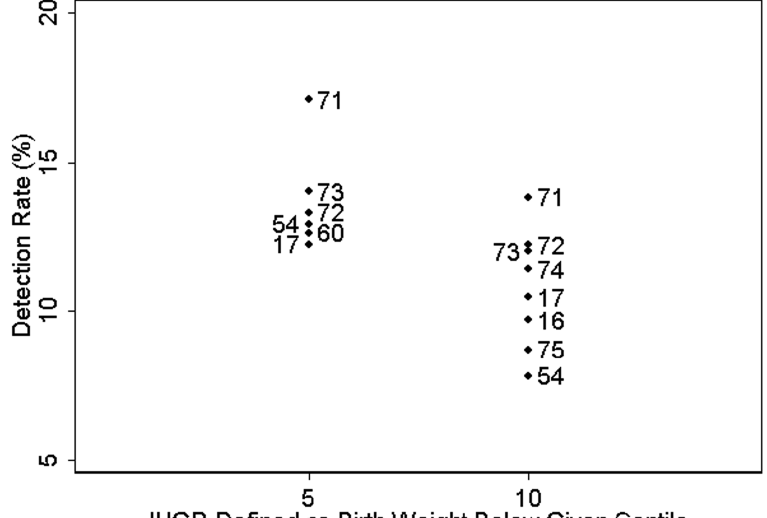
Figure 2. Detection Rate of IUGR using PAPP-A. The numbers indicate the associated